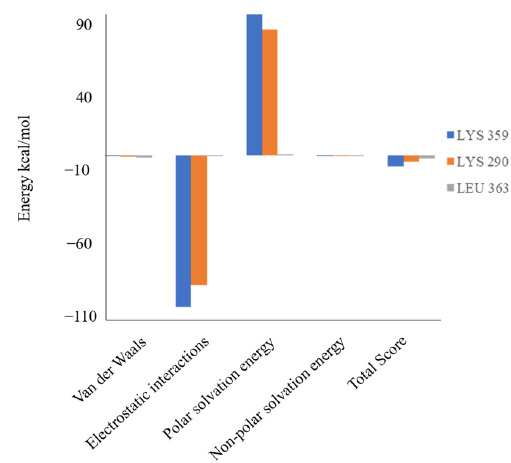
Figure 9. Representative contributions of each energy component for binding free energy.